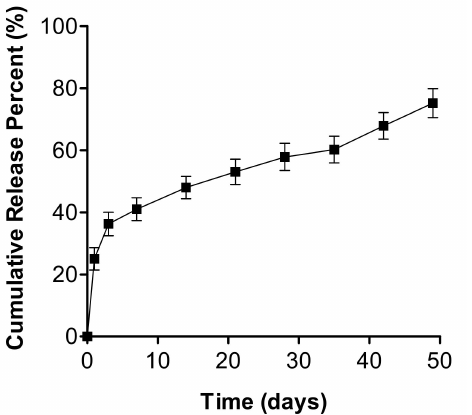
Figure 2. In vitro release of TA from the drug-coated silicone breast implant.